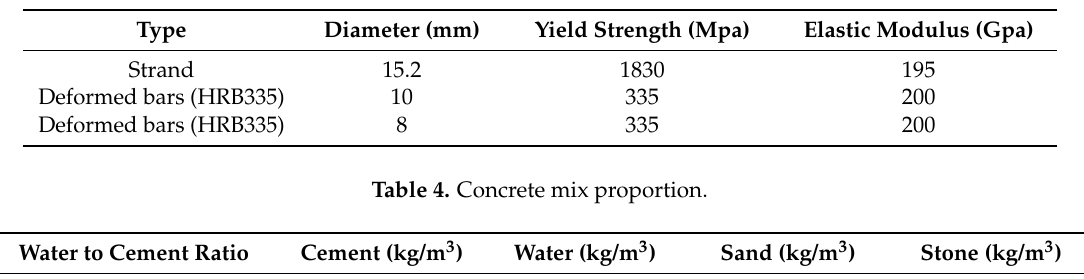
Table 3. Mechanical characteristics of steel [32].